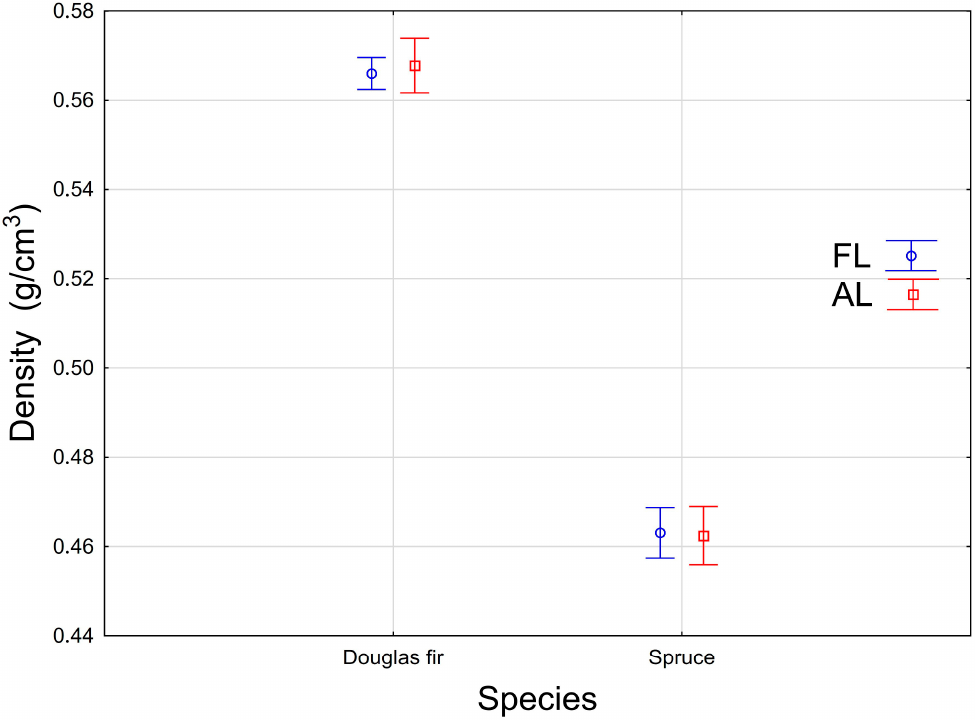
Figure 1. Impact of site on wood density.